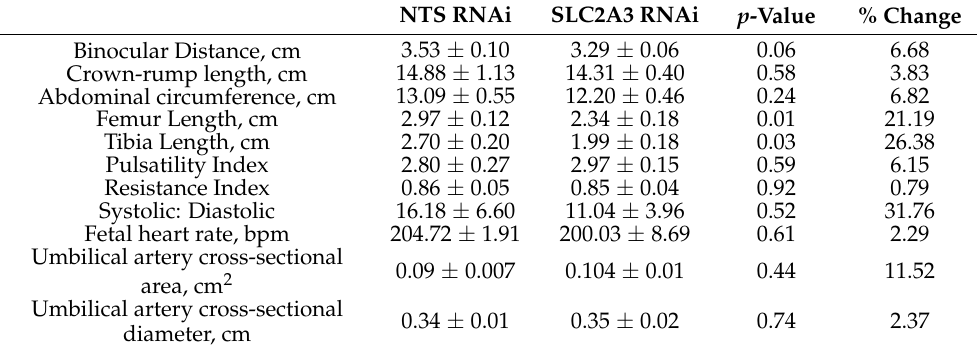
Data are shown as means ± SEM for all ewes in each treatment group. NTS, non-targeting sequence; RNAi, RNA interference. SLC2A3 RNAi resulted in a 37% reduction in placental SLC2A3 ( p ≤ 0.05; Figure 2), as well as a 38% increase in SLC2A1 concentration ( p ≤ 0.10; Figure 2) in the SLC2A3 RNAi pregnancies. Additionally, there was no effect of SLC2A3 RNAi on placental SLC2A8 ( p ≥ 0.10; Figure